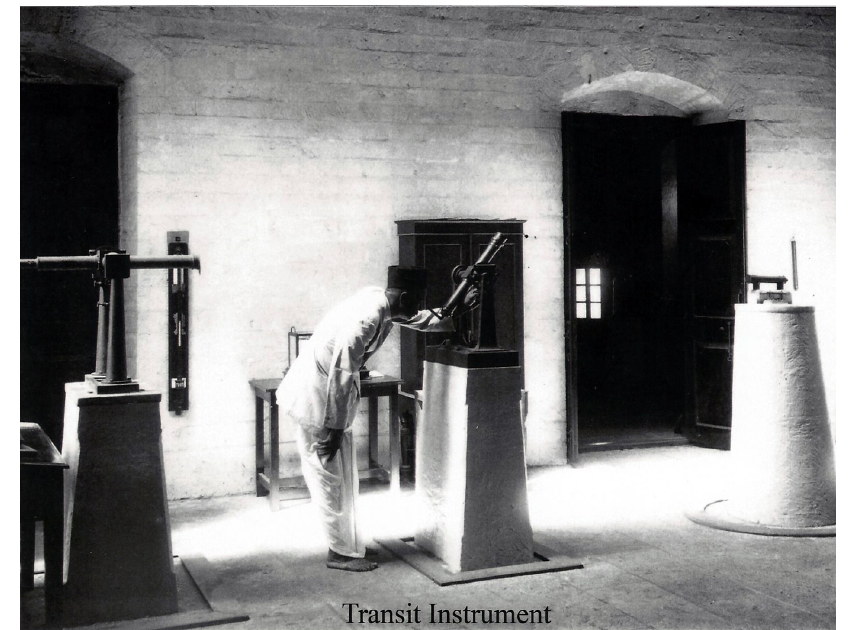
Figure 21. An observer busy at observing the transit of stars to provide accurate time at Alibag. The chronometer and pendulum were used for correct time. This accurate time was conveyed to the public by ringing a bell at 21:00. The ringing of the bell continued till the 1980s. Later on, a siren was blown at 10:00 on request from local authorities. These days digital displays serve this function (courtesy of Colaba–Alibag